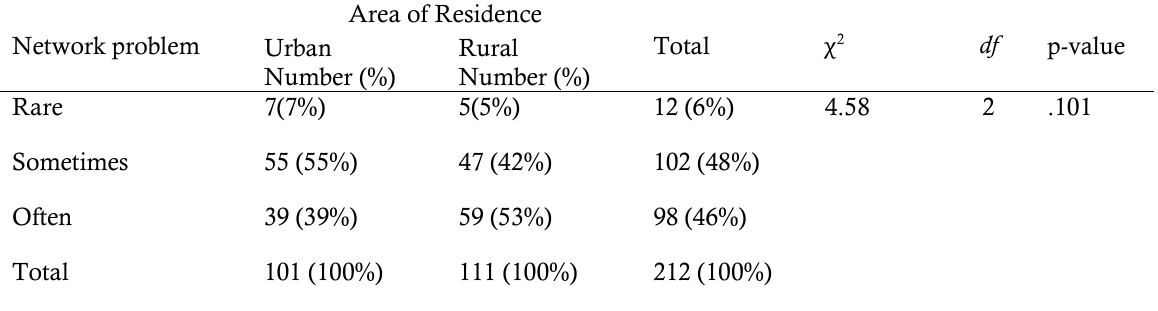
Table 3 <Comparison of Network Problem Among Urban and Rural Areas During Online Classes> Network